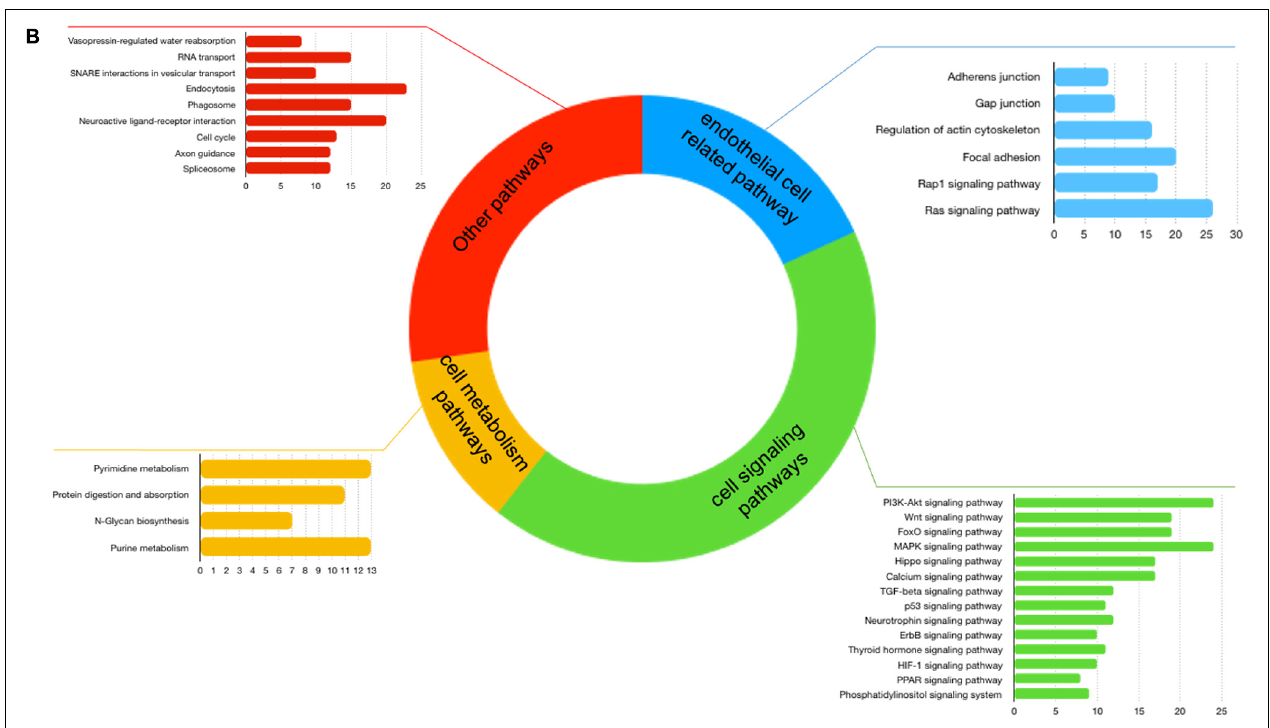
FIGURE 5 | MiRNAs expression mediated by γ -valerolactones treatment in human brain microvascular endothelial cells and their relationship with endothelial cell functions. HBMEC cells exposed to the mixture of gut metabolites ( γ -valerolactones) for 20 h and induced under stress by 4 h-incubation with TNF- α were used in microarray analysis to determine the differential expression of miRNAs between groups. Subsequently, the miRNAs targets were obtained from an analysis of databases (miRTarbase, TargetScan, and miRDb). An enrichment pathway analysis of miRNAs targets in GeneTrial was also performed. (A) Network of miRNAs differentially expressed and their targets. A network built-in Cytoscape software. Hubs network components are highlighted by red squares. (B) Histogram that shows the number of genes mapped to the enriched pathways classified as endothelial cell-related (blue), cell signaling (green), cell metabolism (yellow), and other pathways